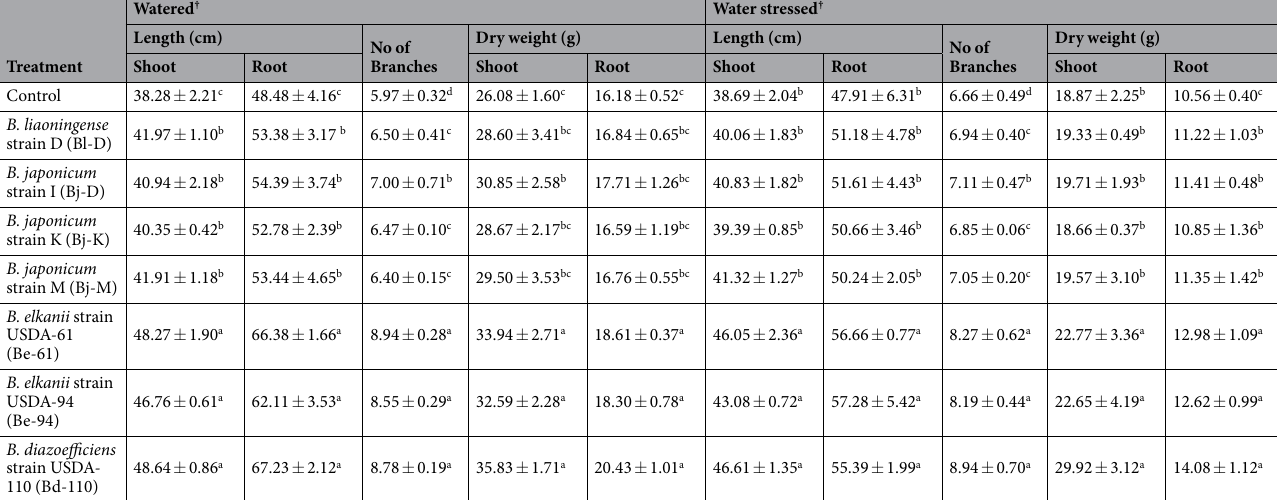
Table 3. Inoculation effects of non-rhizobitoxine- and rhizobitoxine-producing Bradyrhizobium strains on the available nitrogen in the rhizosphere and total nitrogen content of soybean plants under watered and water- stressed conditions. † Values are the means of six-replication ± standard error. Values with the same superscripts within column indicate no significant difference at P ≥